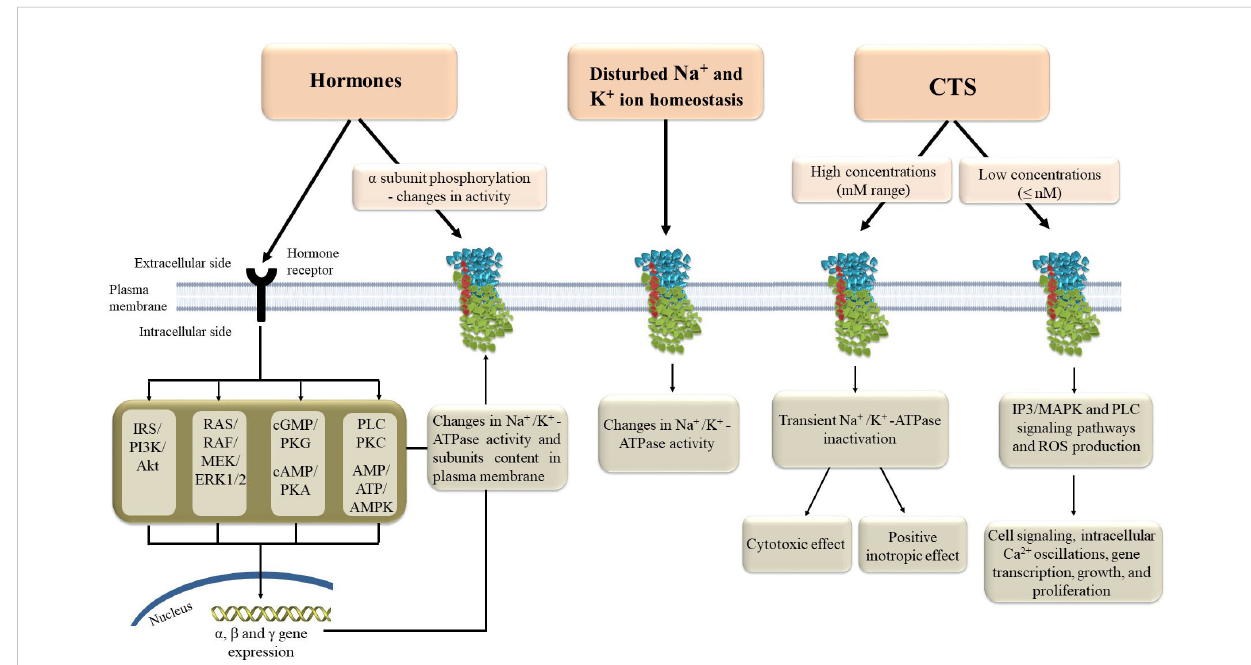
FIGURE 2 Molecular mechanisms of Na + /K + -ATPase regulation. AMP - adenosine monophosphate, AMPK – AMP-activated protein kinase, ATP - adenosine triphosphate, CTS – cardiotonic steroids, ERK1/2 – extracellular signal-regulated kinases 1 and 2, IP3 – inositol triphosphate, MAPK – mitogen- activated protein kinase, PKA, protein kinase A; PKC, protein kinase C; PKG, cGMP-activated protein kinase; PLC, phospholipase C; ROS, reactive oxygen